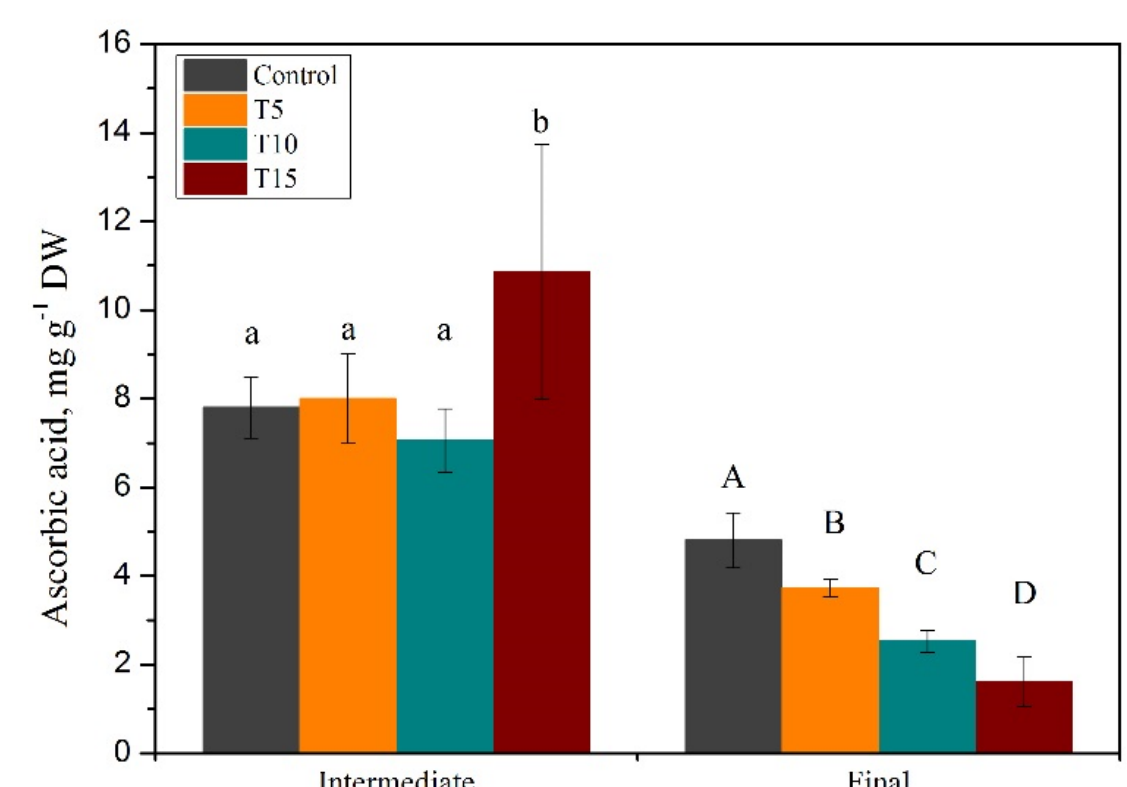
Figure 4. Ascorbic acid content of basil leaves grown under the various salinity treatments at the intermediate and final harvests. Values are expressed as mean ± standard deviation ( n = 5). Different letters indicate statistically significant differences between treatments at each harvest (small letters refer to the intermediate and capital ones to the final harvest, p < 0.05).